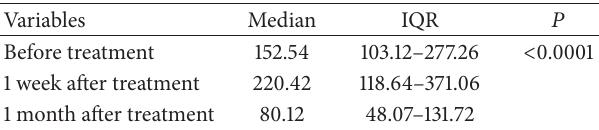
Table 4: The serum levels of SALL4 of 40 HCCs before and after treatment (pg/mL).